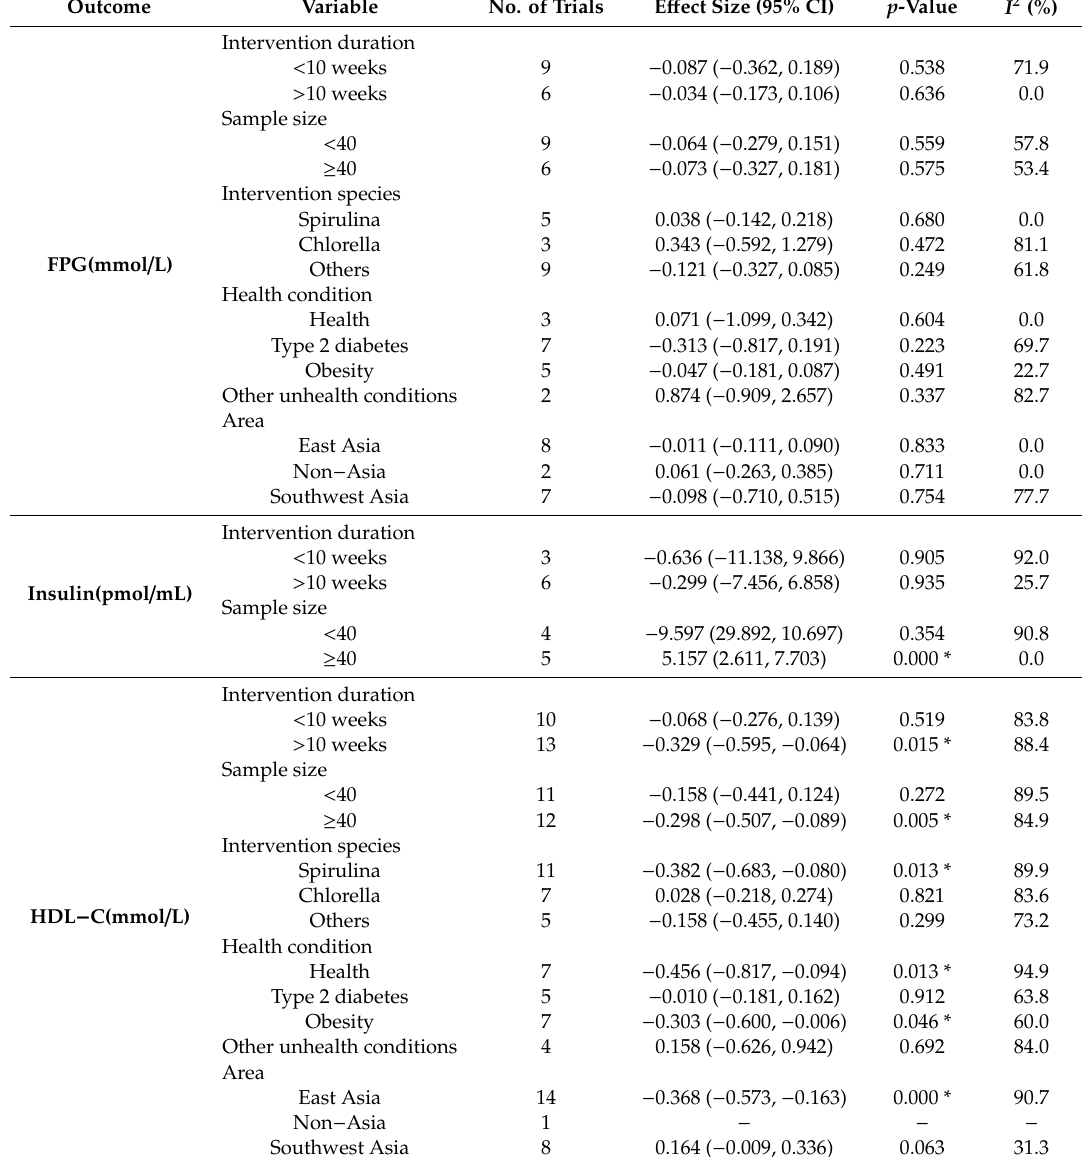
Table 2. Results of the effect of algae and its extracts supplementation on outcomes based on subgroup analyses. Outcome Variable No. of